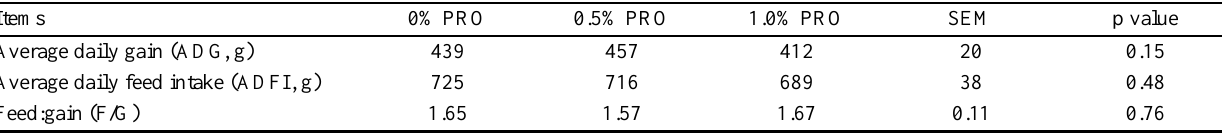
Table 2. Effects of L-proline supplementation on growth performance of piglets during 0-10 d 1 Items